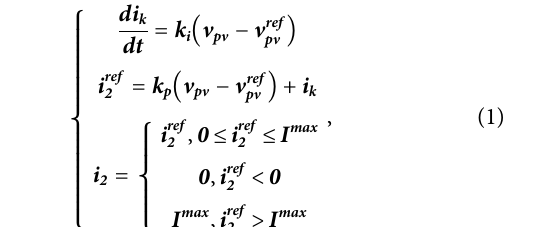
Figure 1 . Therefore, the system dynamics during large disturbances are mainly dominated by the slow outer loops.